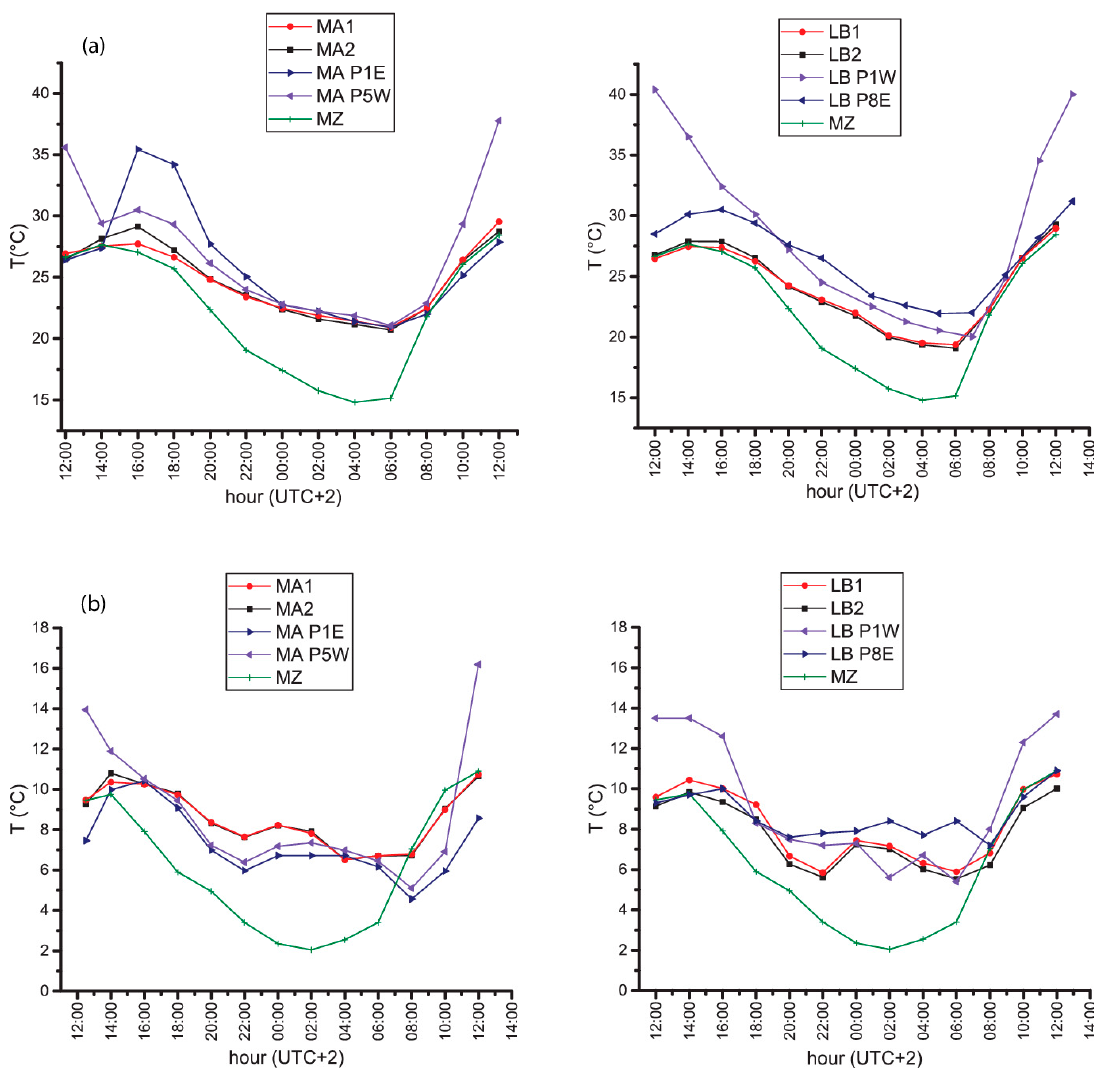
Figure 5. Temperature evolution within the day of the summer (22–23 August 2017) ( a ) and winter (8–9 February 2018) ( b ) intensive thermographic campaign in the two street canyons in Bologna (Marconi St. on the left and Laura Bassi St. on the right), measured by the thermo-hygrometers located at ground and mid-level (respectively site 1 and 2), the Agenzia Regionale per la Prevenzione, l’Ambiente e l’Energia dell’Emilia-Romagna (ARPAE) instrumentation in one rural meteorological station (MZ) and of building façades of buildings located on the west and east side of the two street canyons as retrieved from the thermal images acquired with the two thermal cameras.